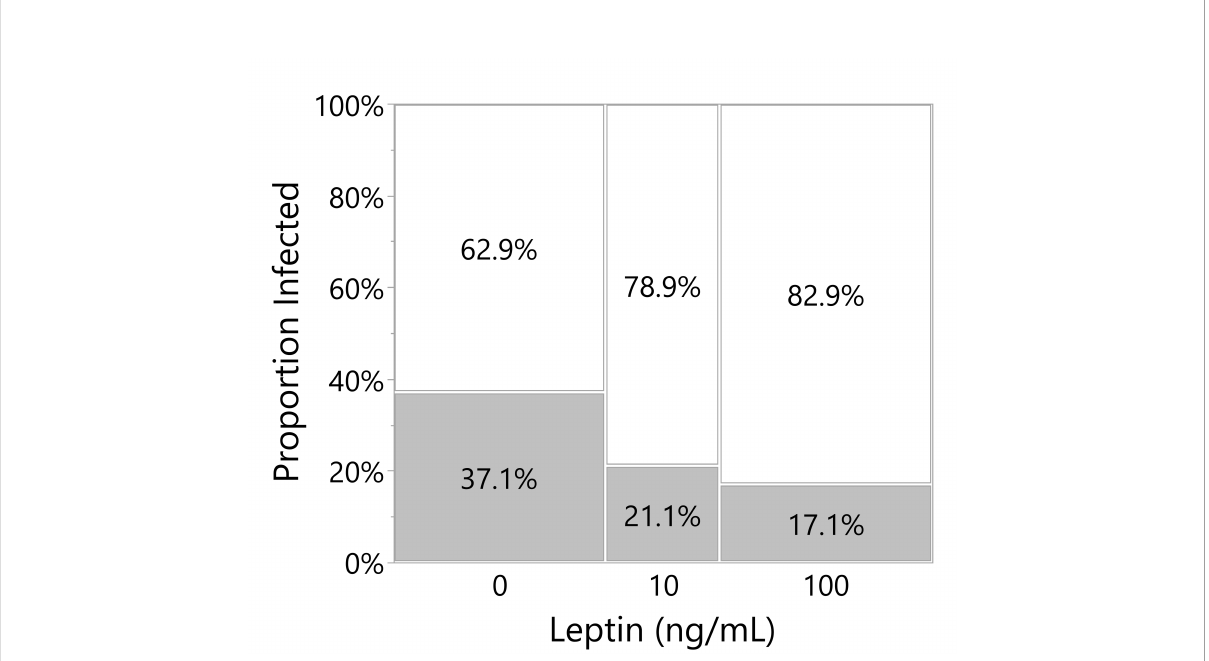
FIGURE 7 Leptin suppresses microbial growth in culture media of skin explants. Proportion of culture wells visually turbid with bacterial infection for juvenile Xenopus laevis dorsal skin wound explant cultured in increasing leptin concentration at 48 hpi. Increasing leptin concentration (0 ng/ml, n = 70; 10 ng/ml, n = 38; 100 ng/ml, n = 70) signi fi cantly decreased the number of infected wells (likelihood ratio test, p =